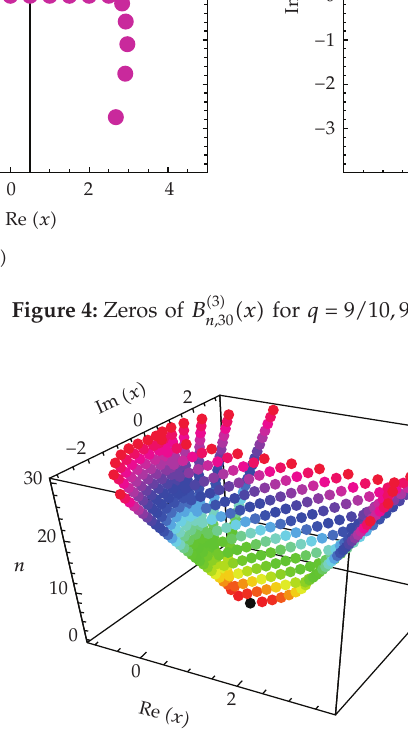
Figure 5: Stacks of zeros of B